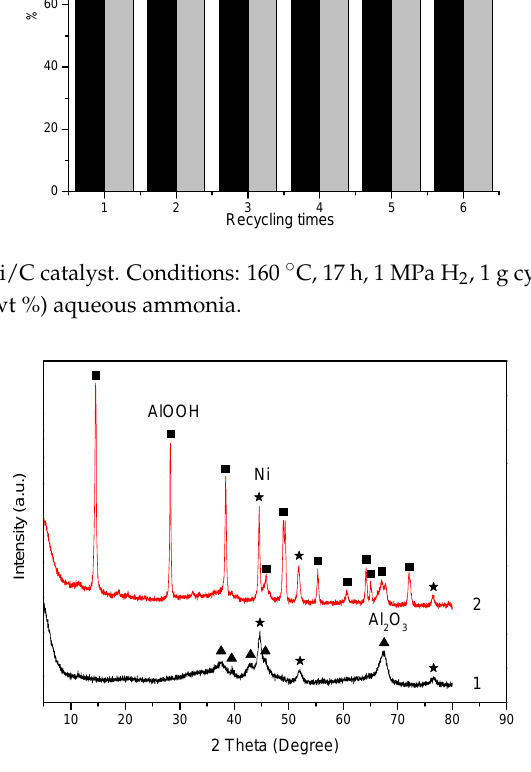
Figure 4. XRD patterns of ( 1 ) fresh Ni/Al 2 O 3 ; ( 2 ) Ni/Al 2 O 3 after the reaction.